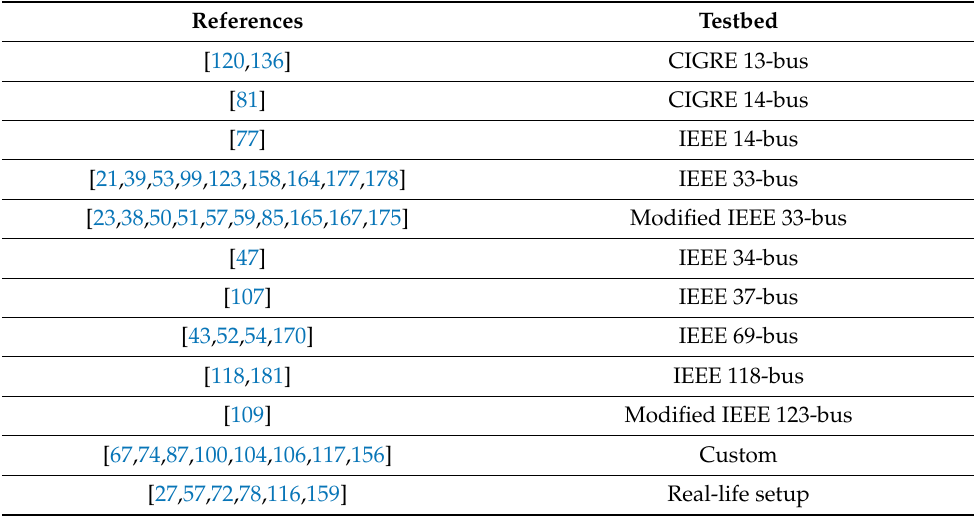
Table 11. Grid testbeds employed to validate the different models.